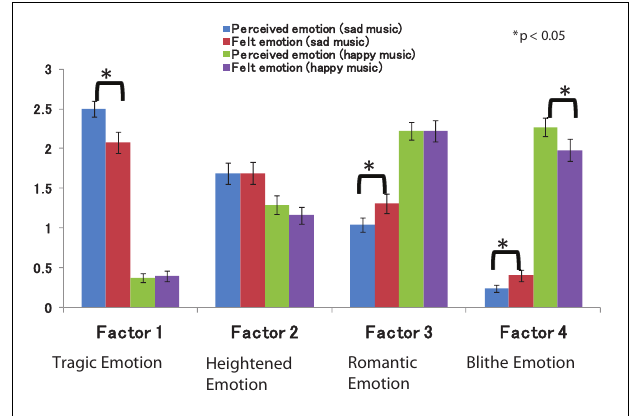
FIGURE 1 | Mean factor scores for perceived and felt emotions.